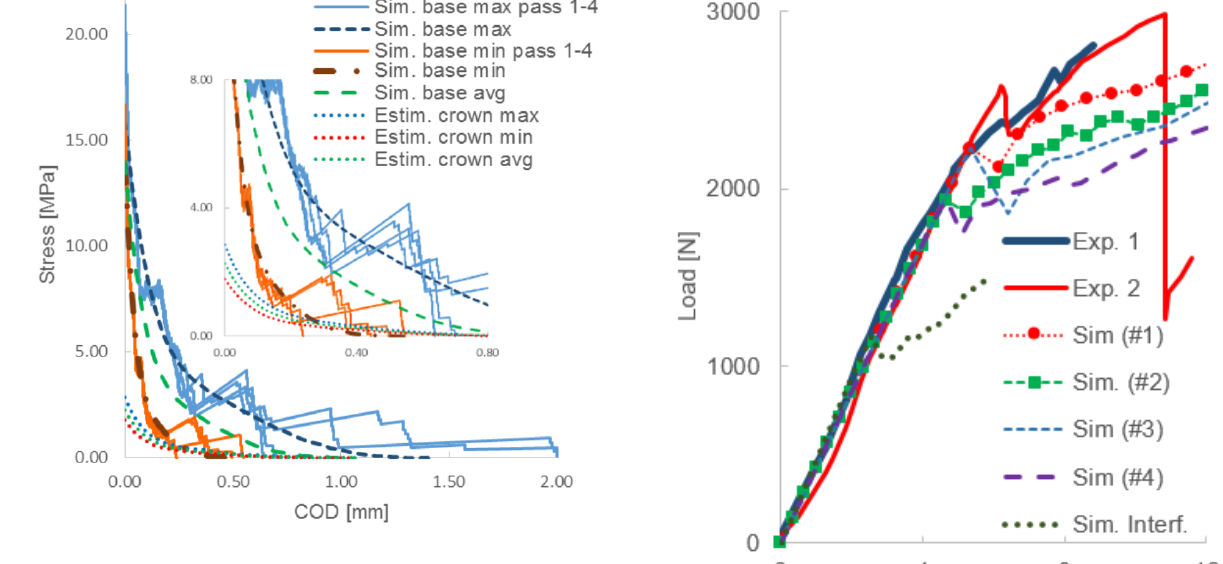
Figure 3. Traction-separation relationships (stress vs. COD) of CT specimens cut from arch base and crown: (i) experimental (Exp.), (ii) numerically simulated by means of sequentially linear approach to inverse analysis (Sim.) and (iii) estimated by trial-and-error approach to inverse analysis (Estim.).